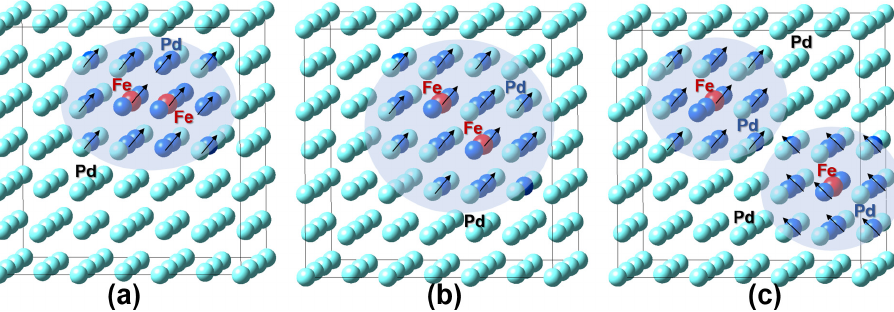
Figure 5. Magnetic clusters formed around Fe solute atom impurities in the 3 × 3 × 3 Pd host matrix. Three configurations are shown: ( a ) Fe atoms are located close to each other; ( b ) further away; ( c ) at a distance. Red spheres of atoms correspond to Fe, light blue to Pd, and blue to predominantly polarized Pd atoms. Transparent blue spheres outline magnetic clusters formed around magnetic impurities, and black arrows denote one special case of magnetic moments